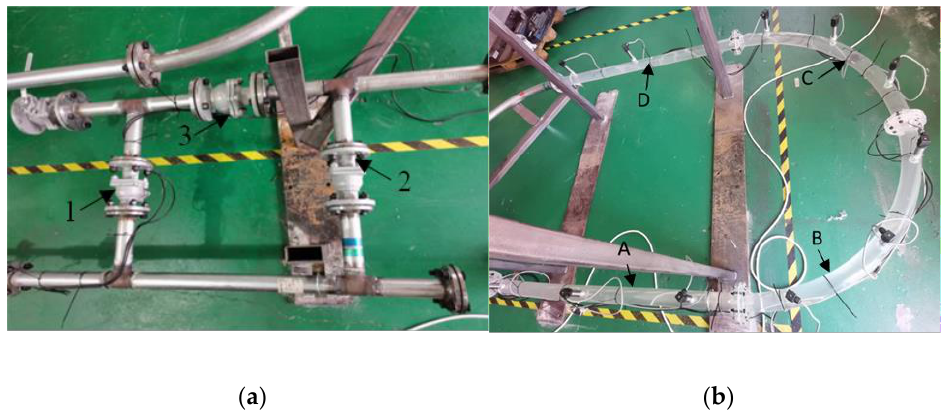
Figure 2. Serving system and observation areas A, B, C, D: ( a ) 1, 2 and 3 are ball value 1, 2 and 3; ( b ) A, B, C and D are the four observation areas.